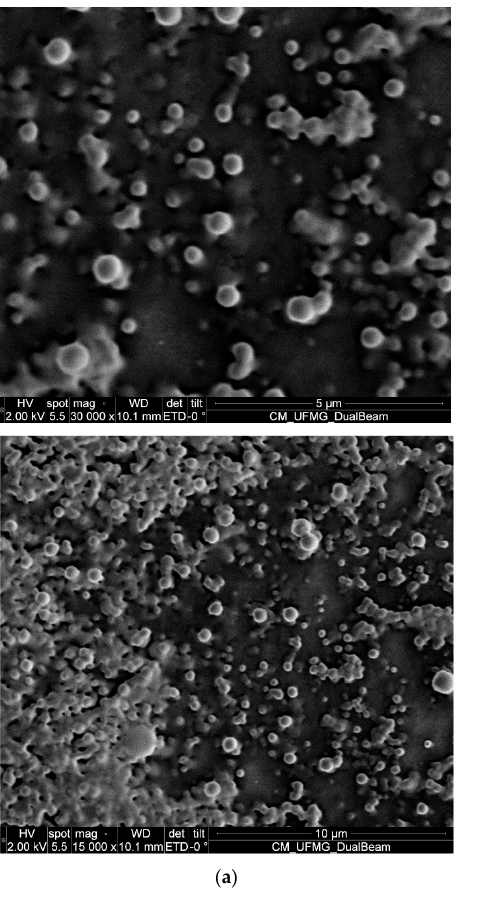
Figure 1. ( a ) Scanning electron microscope (SEM) of suspensions of PCL nanospheres containing the essential oil of Z. rhoifolium fruits. ( b ) UV-accelerated degradation of the essential oil in the free (EO) and nanoencapsulated forms